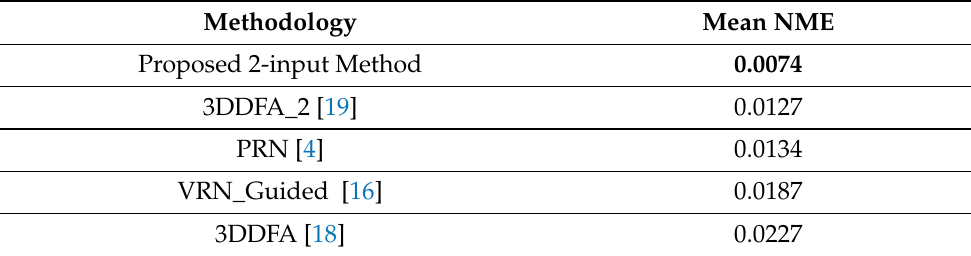
Figure 22. Examples of meshes that were reconstructed using three faces from the MICC Florence dataset. The top row shows the input images for the networks. PRN uses a single front-facing image as input, whereas our network is fed both the front and side images. The transfer trained network output is shown in the second row, the ground truth facial mesh in the third row and the PRN output in the fourth row. Table 3. NME comparison for our transfer trained 2-input network and the current state-of-the-art. Best performance is highlighted in